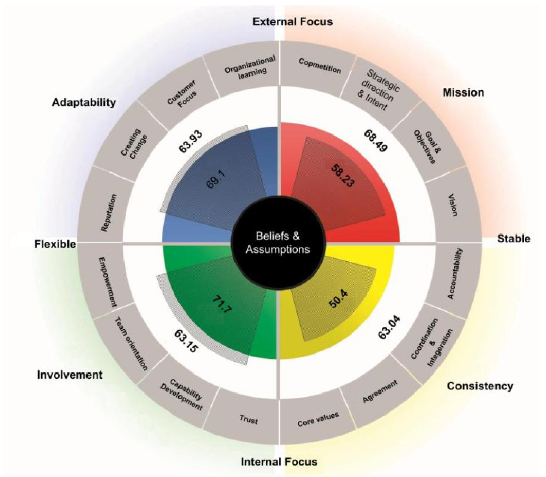
Fig. 5. Comparing Status Quo Trait Scores with Favorite Organizational Culture Using Benchmarking Technique